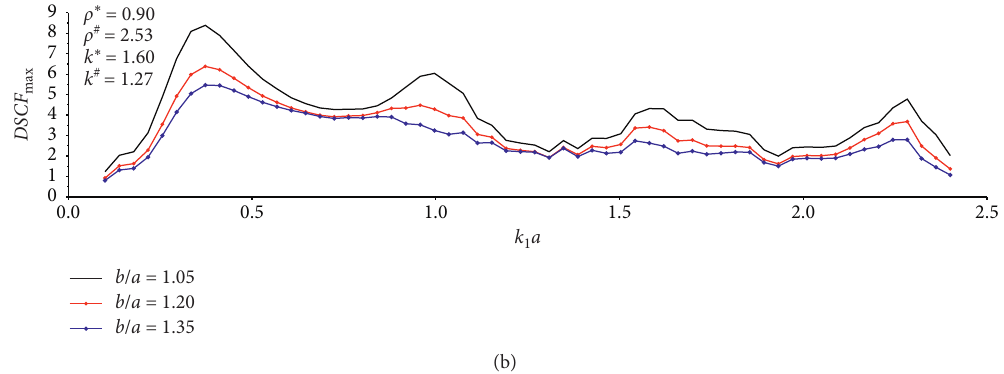
a on the inner surface of linings for geological Condition A. (a) Condition A-C30: inner surface. (b) with k max 1